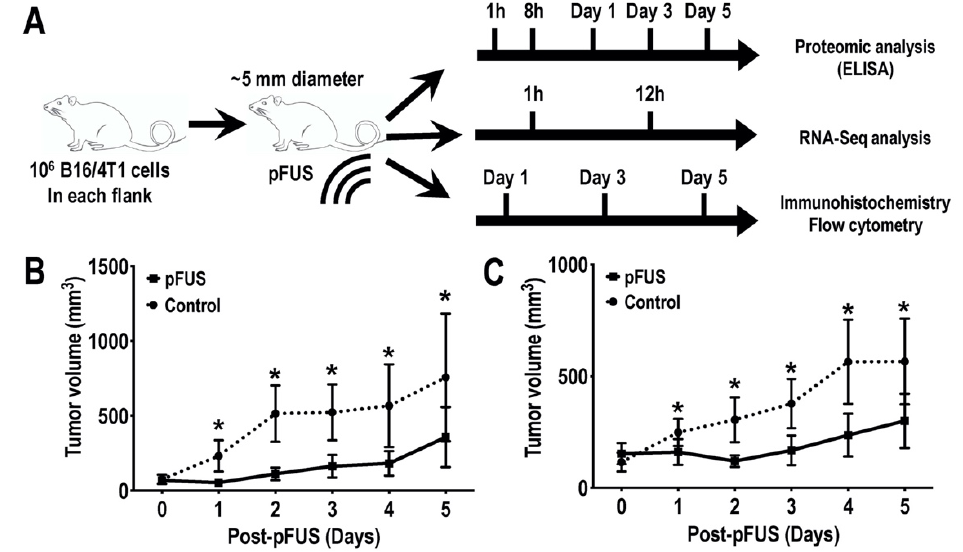
Figure 1. ( A ) Schematic diagram of the experimental set-ups. Murine melanoma B16 or breast 4T1 cells were inoculated into C57BL/6 or BALB/c mice ( n = 6 mice/tumor type/time point), respectively. Mice were treated with 6 MPa pFUS once tumor sizes reached ~5 mm in diameter. Tumors were harvested at different time points post-pFUS and were subjected to proteomic (top), transcriptomic (middle), immunohistochemistry, and flow cytometry (bottom) analyses. Tumor size volumes of ( B ) B16 melanoma ( C ) or 4T1 breast flank tumor model acquired from the third cohort study. Black lines indicate tumor size (mean ± SD) following pFUS treatment on day 0. Dashed black lines indicated an untreated control group. Asterisks indicate statistical significance ( p < 0.05; t -test).